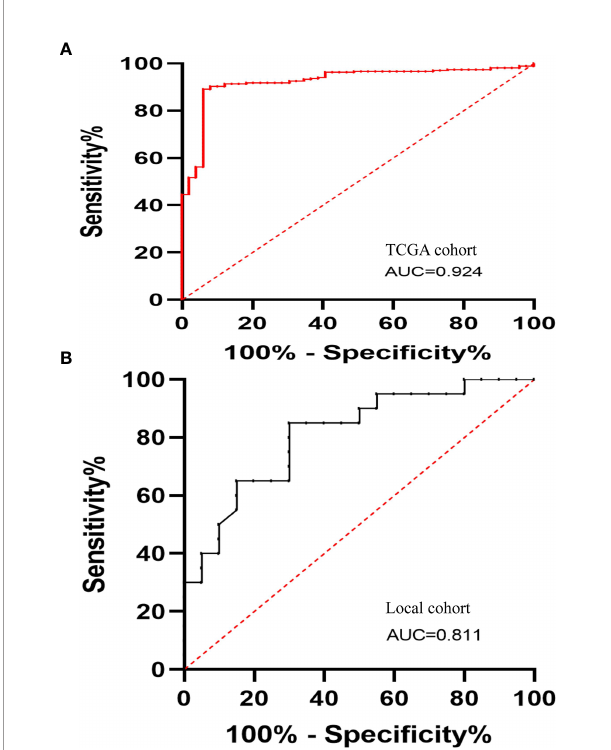
FIGURE 2 | The diagnostic ROC curves of LINC01667 in HCC. (A) Diagnostic ROC curves of LINC01667 for distinguishing patients with HCC and normal controls in a TCGA cohort (normal = 49, tumor = 267). (B) Diagnostic ROC curves of LINC01667 for distinguishing patients with HCC and normal controls in a local cohort (normal = 20, tumor =